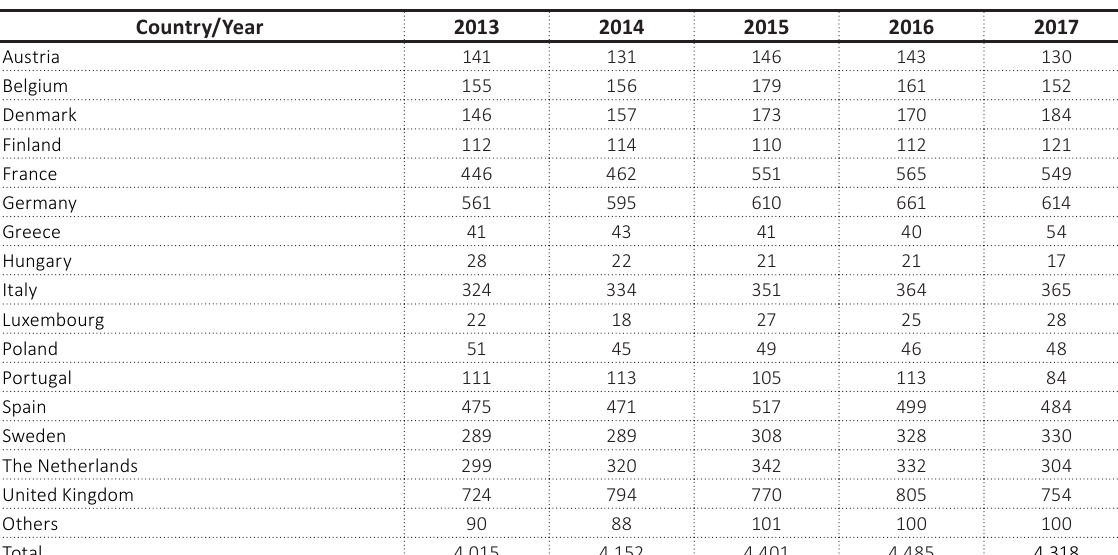
Figure 3. Percentage share of the number of integrated reports of individual member states in the EU as a whole in 2013 Table 3. Number of integrated reports in individual EU member states in 2013–2017 Source: Own